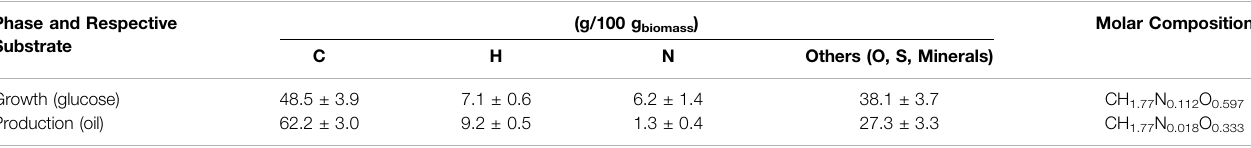
TABLE 1| Average biomass composition(CHN-analysis; n > 20 samples from 12different fermentations) of M. aphidis cells during growth phase (glucose, non-limited) and MEL production phase (oil addition, N-limited). Phase and Respective